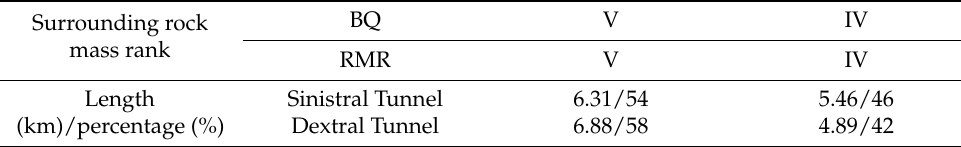
Table 1. Surrounding rock mass ranks under preliminary